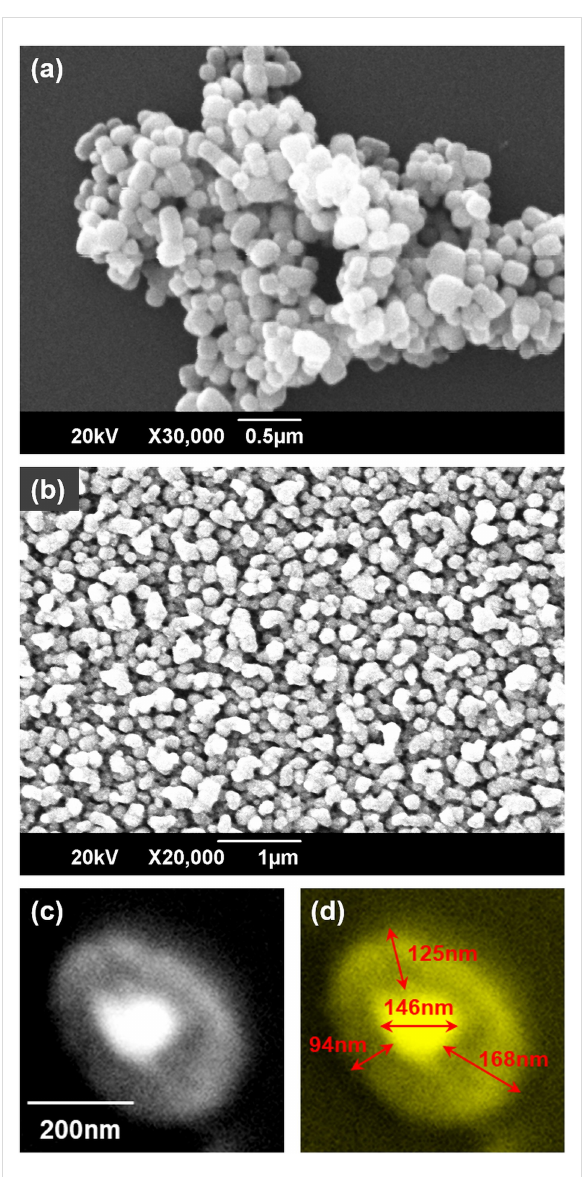
Figure 4: SEM images of the as-prepared BTO nanoparticles (a) and the core–shell BTO-PTh nanoparticles (b). The core–shell structure of BTO-PTh nanoparticles is demonstrated in panels (c,